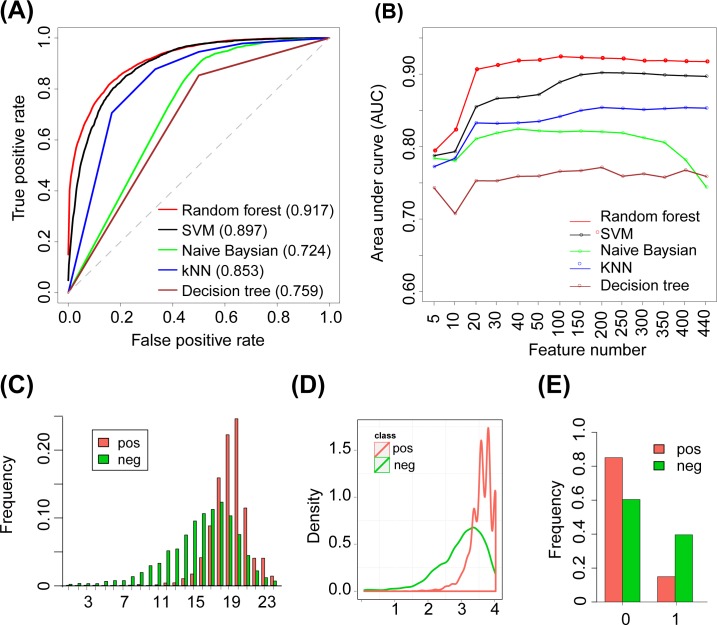
Performance of ML-based miRNA predictors in classifying real and pseudo miRNA duplexes.(A)ROC curve displaying the performance of different ML-based miRNA predictors in the ten-fold cross-validation experiment.(B) Performance of ML-based miRNA predictors obtained with different numbers of features.(C) Distribution of the number of base pairs in the positive and negative sample sets.(D) Distribution of the average number of base pairs in a 4-nt sliding window in the positive and negative sample sets.(E) Frequency of bulges 1nt upstream of the miRNA end in the positive and negative sample sets.